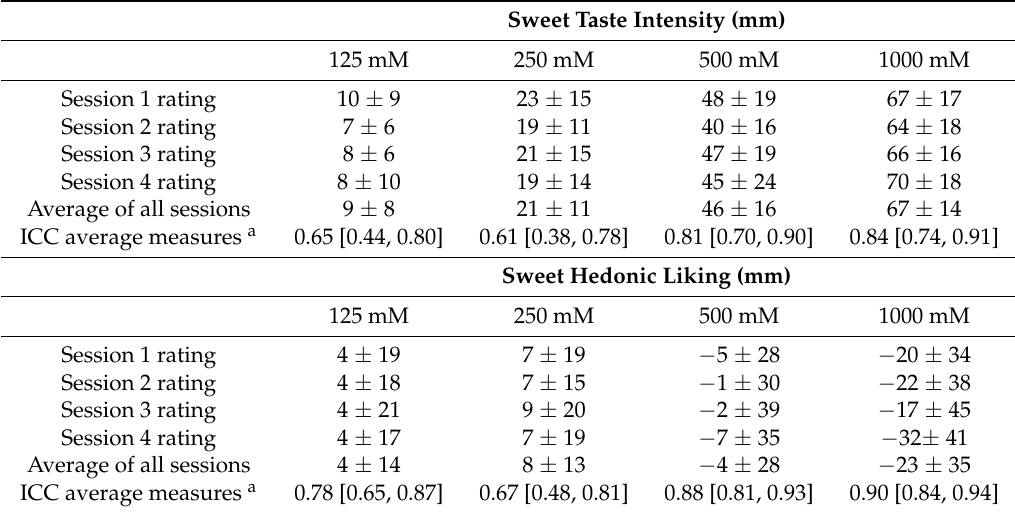
Table 2. Sweet taste intensity and hedonic liking ratings at the four different